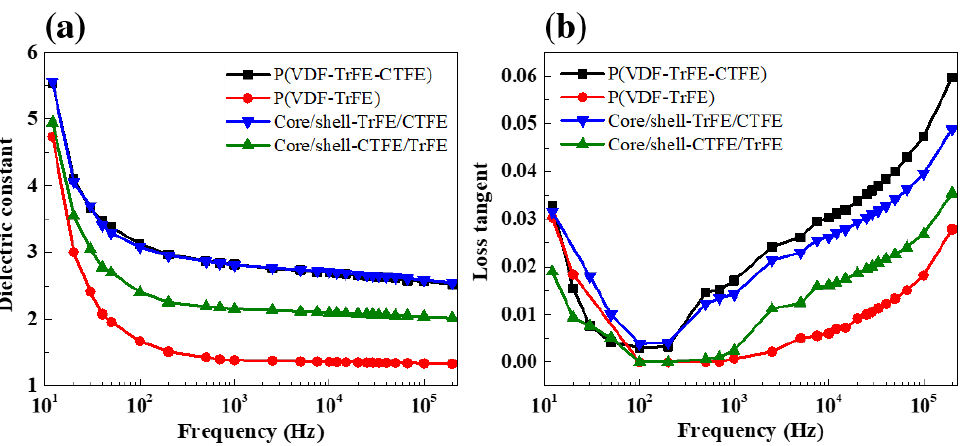
Figure 7. ( a ) Dielectric constant and ( b ) dielectric loss as a function of frequency in the single and coaxial electrospun coaxial electrospun nanofibers.